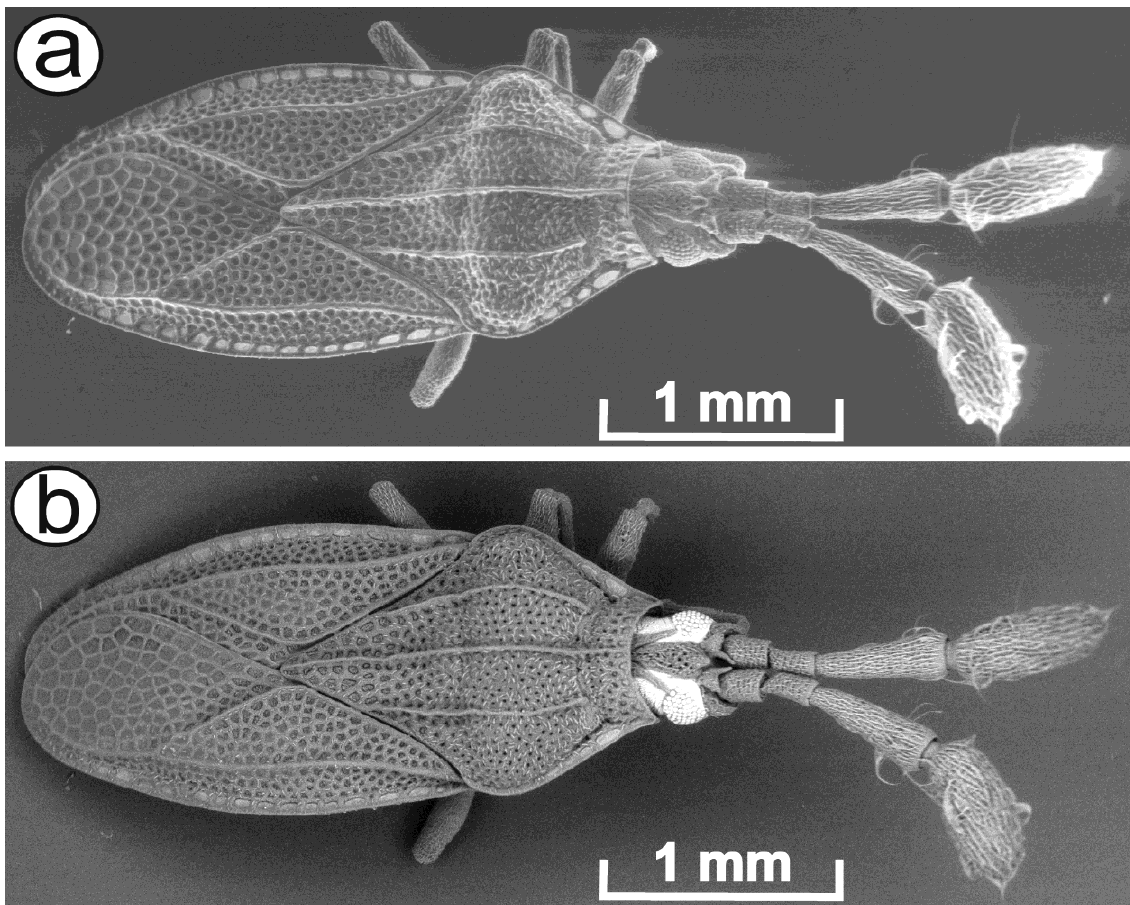
FIGURE 2. Copium adult specimen. (a) ESEM image of the whole Copium insect using the SED, displaying only topographic details. (b) The same ESEM image using the BSED, highlighting the eyes by their higher amount of Ca and P elements in comparison with the proteinaceous carbon